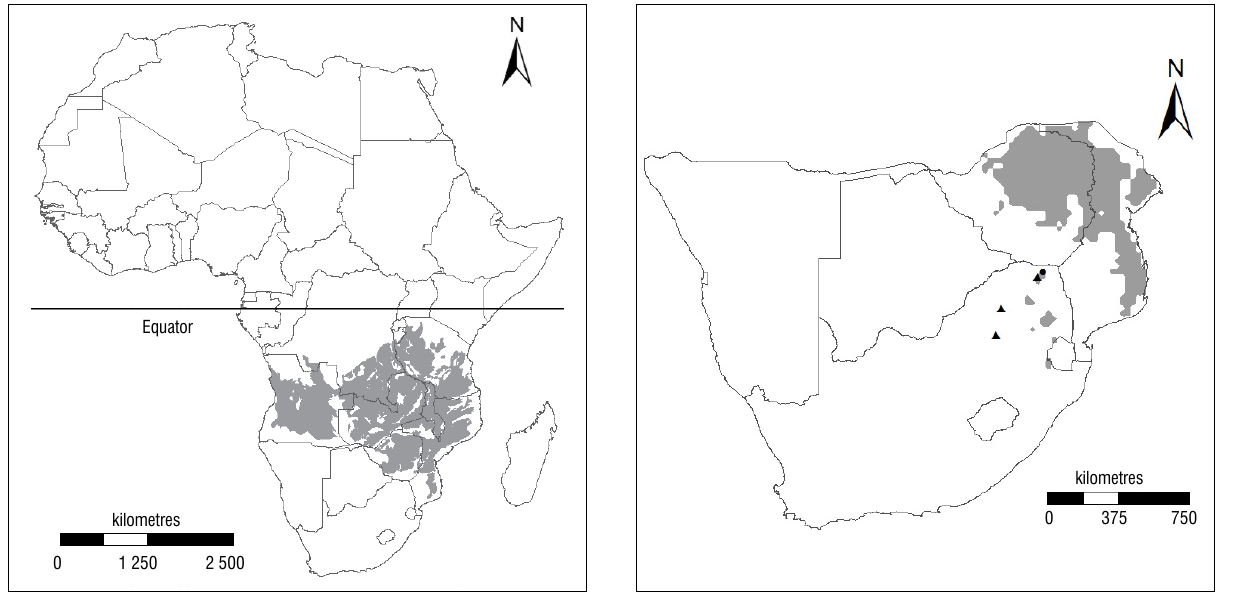
Figure 2: Ecological niche of Brachystegia spiciformis woodlands in southern Africa under present-day climate conditions. Location of the Gundani climate relict population (black circle) and three Mid-Holocene pollen records (black triangles) are included.